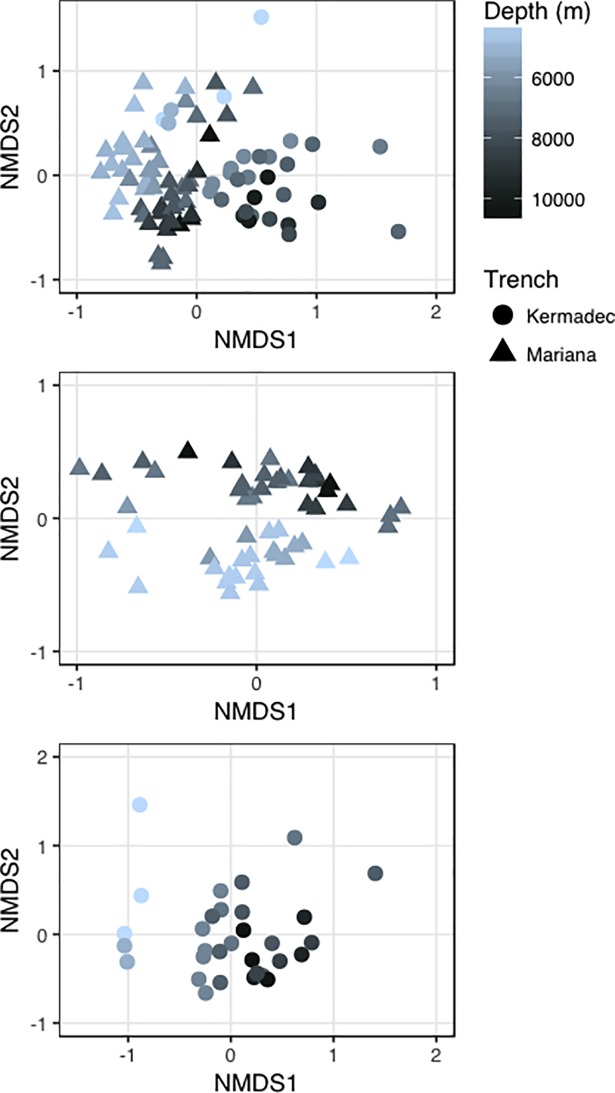
Ordinations of sequenced abyssal and hadal communities.Distances between abyssal and hadal communities visualized via ordinations using Bray-Curtis dissimilarity. A, Mariana Trench; B, Kermadec Trench; C, both trenches.